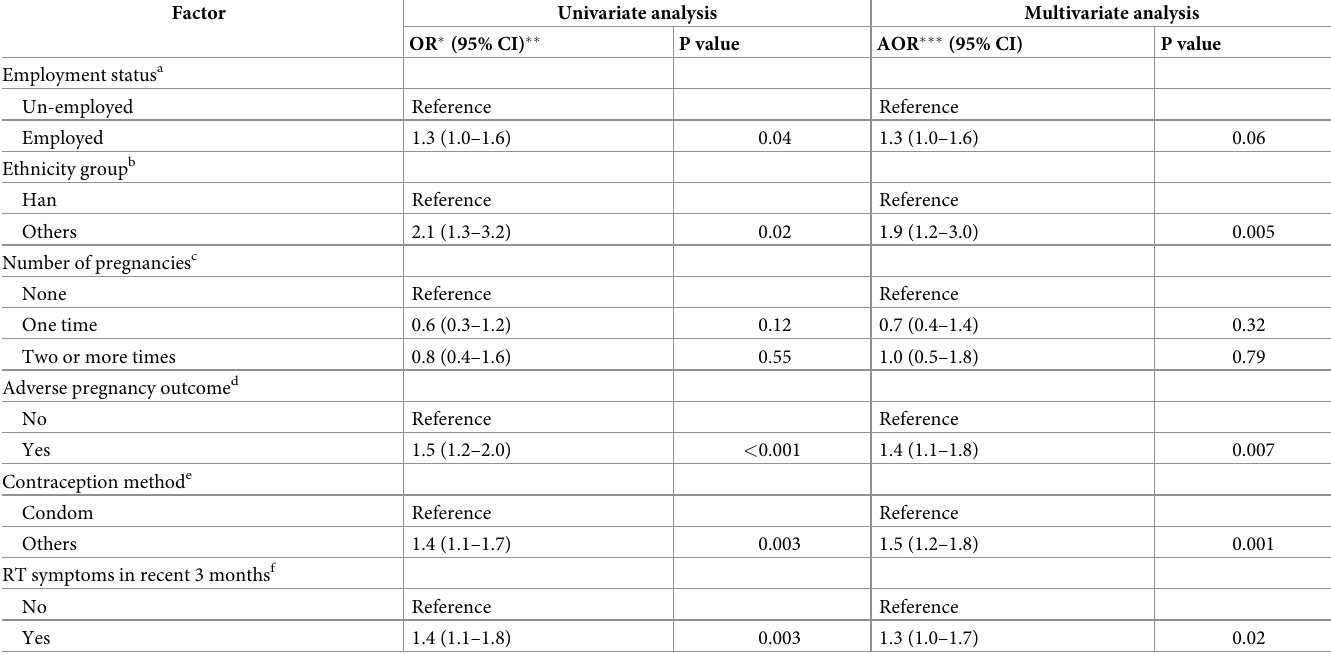
Table 2. Factors associated with positivity of C . trachomatis : univariate and multivariate logistic regression